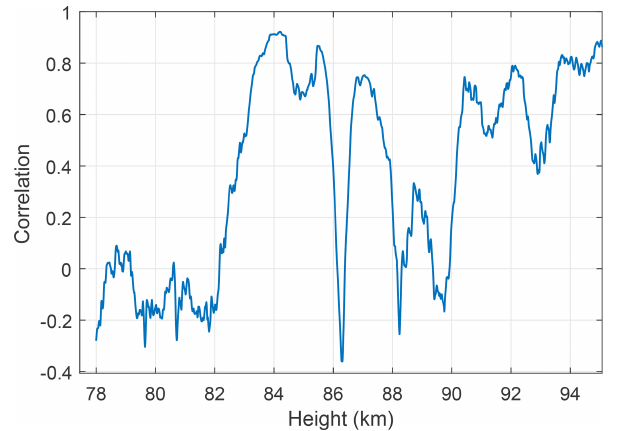
Figure 9. Correlation between the total current channels ( U R = − 2V) on MUDD-1 and MUDD-3 evaluated for a moving window of 1000 samples corresponding to ∼ 100m in altitude.